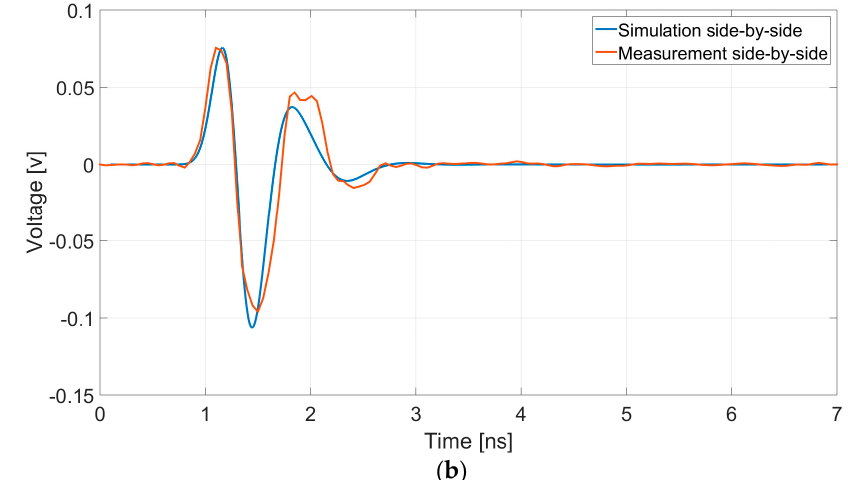
Figure 7. Comparison of simulation and measurement results for air testing: ( a ) Face-to-face configuration; ( b ) side-by-side configuration.